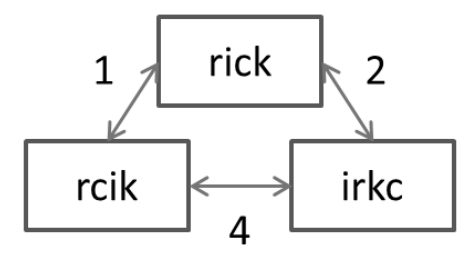
Figure 6 . Damerau-Levenshtein Distance Implementation